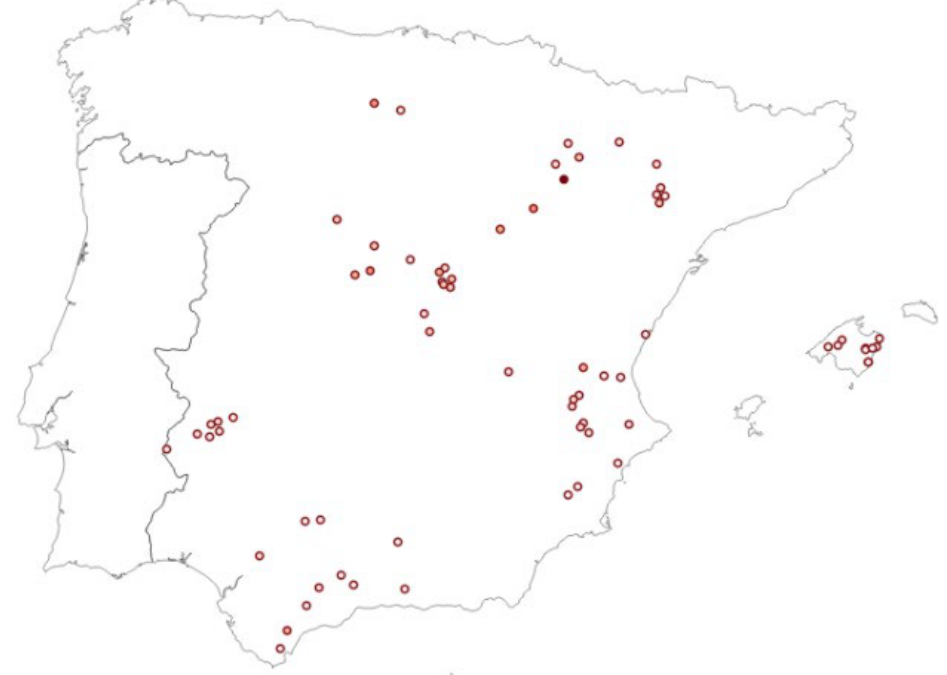
Figure 1. Geographical location of the grid-connected PV installations whose projects were analyzed in the study.